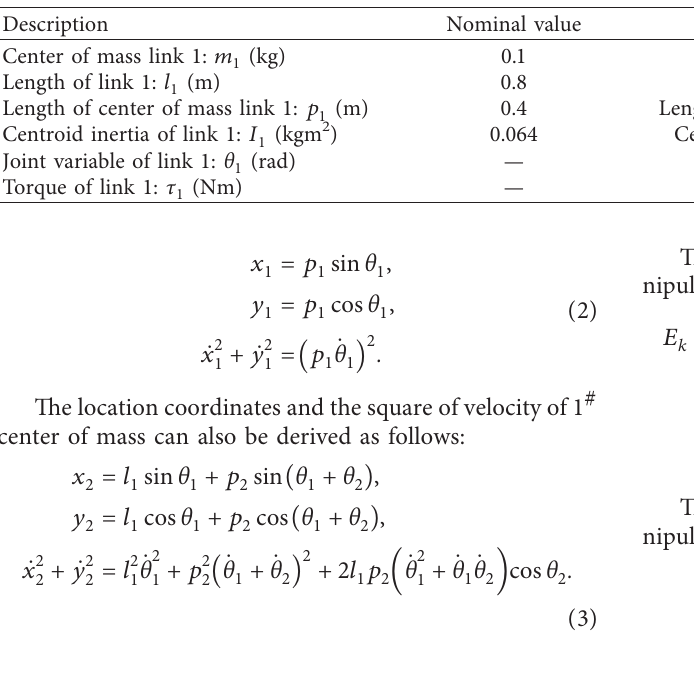
Figure 2: Two-link robotic manipulator plant with contact force at tip. Table 1: Variables description of two-link robotic manipulator [39].